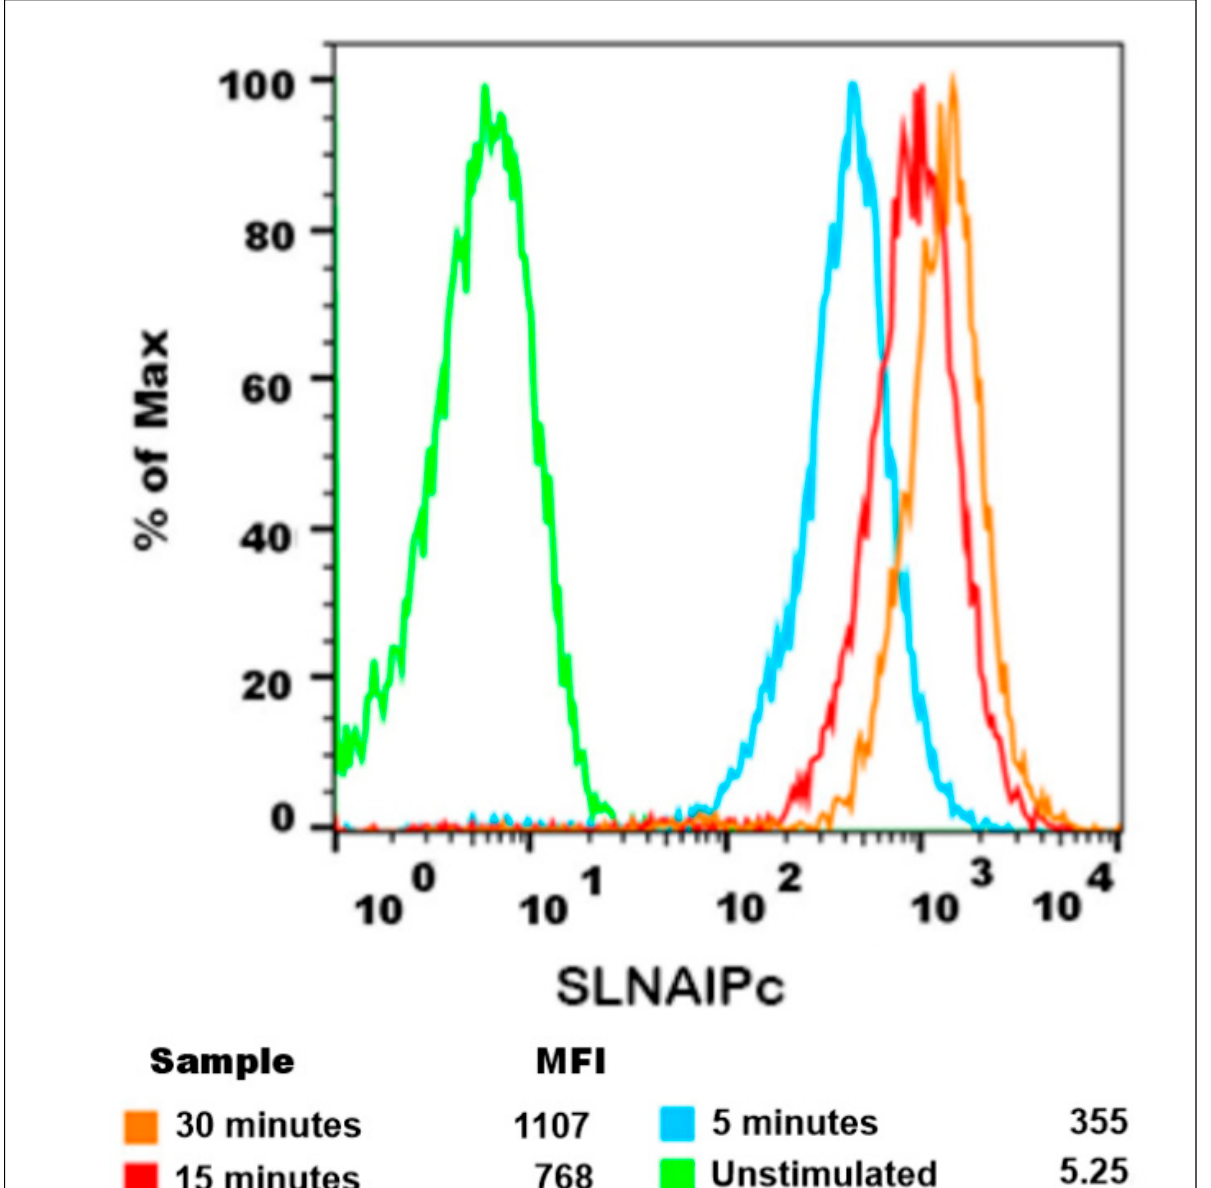
Figure 7. Internalization of SLN-AlPc. The fluorescence histogram showed the internalized amount of SLN-AlPc at different time points after the SLN-AlPc treatment. The fluorescence signal increases proportionally to the time that the B16-F10 were exposed to SLN-AlPc.